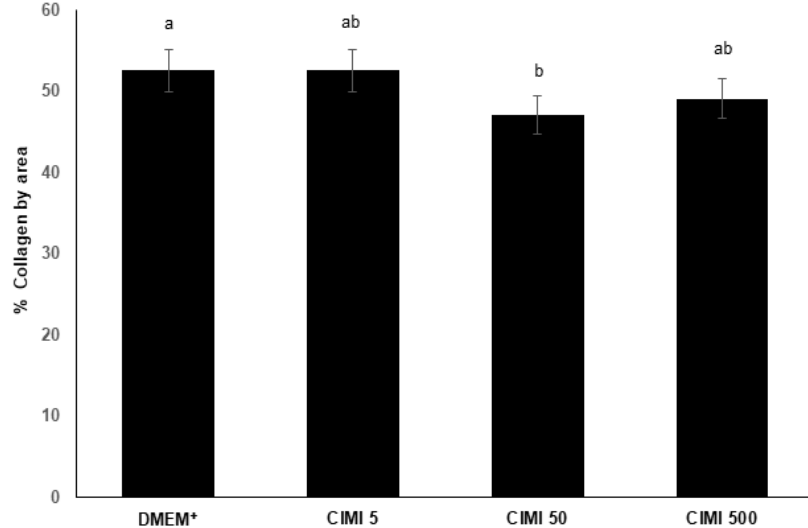
Figure 3. The levels of collagen fibers (mean ± SD) in the mouse ovaries (n = 9 ovaries per treatment) cultured for 6 days in DMEM + alone or supplemented with CIMI (5 ng/mL, 50 ng/mL or 500 ng/mL). Collagen fiber distribution was analyzed by the Kruskal-Wallis test, followed by Dunn’s comparison. a and b different lowercase letters indicate statistically significant differences between treatments ( p <